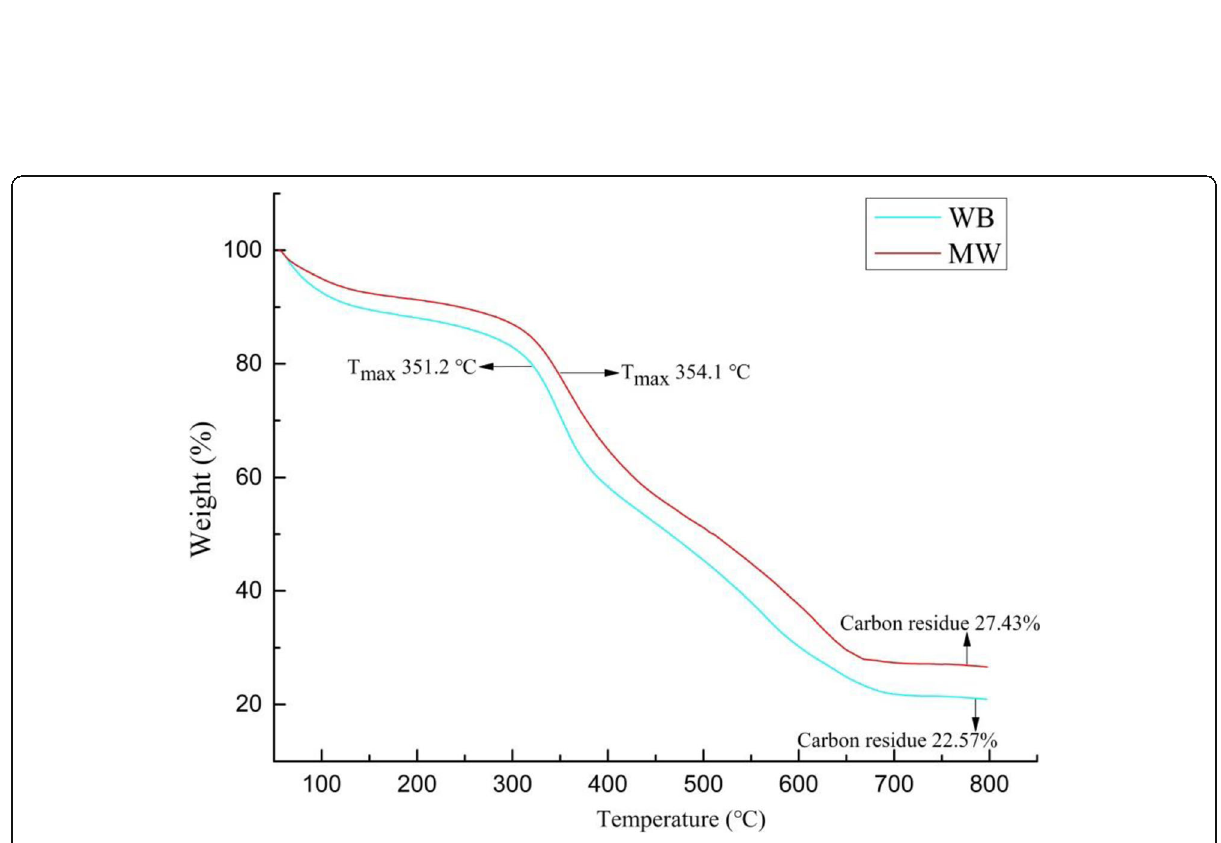
Fig. 5 The thermal decomposition process of hide powder tanned by chrome tanning liquor treated by different